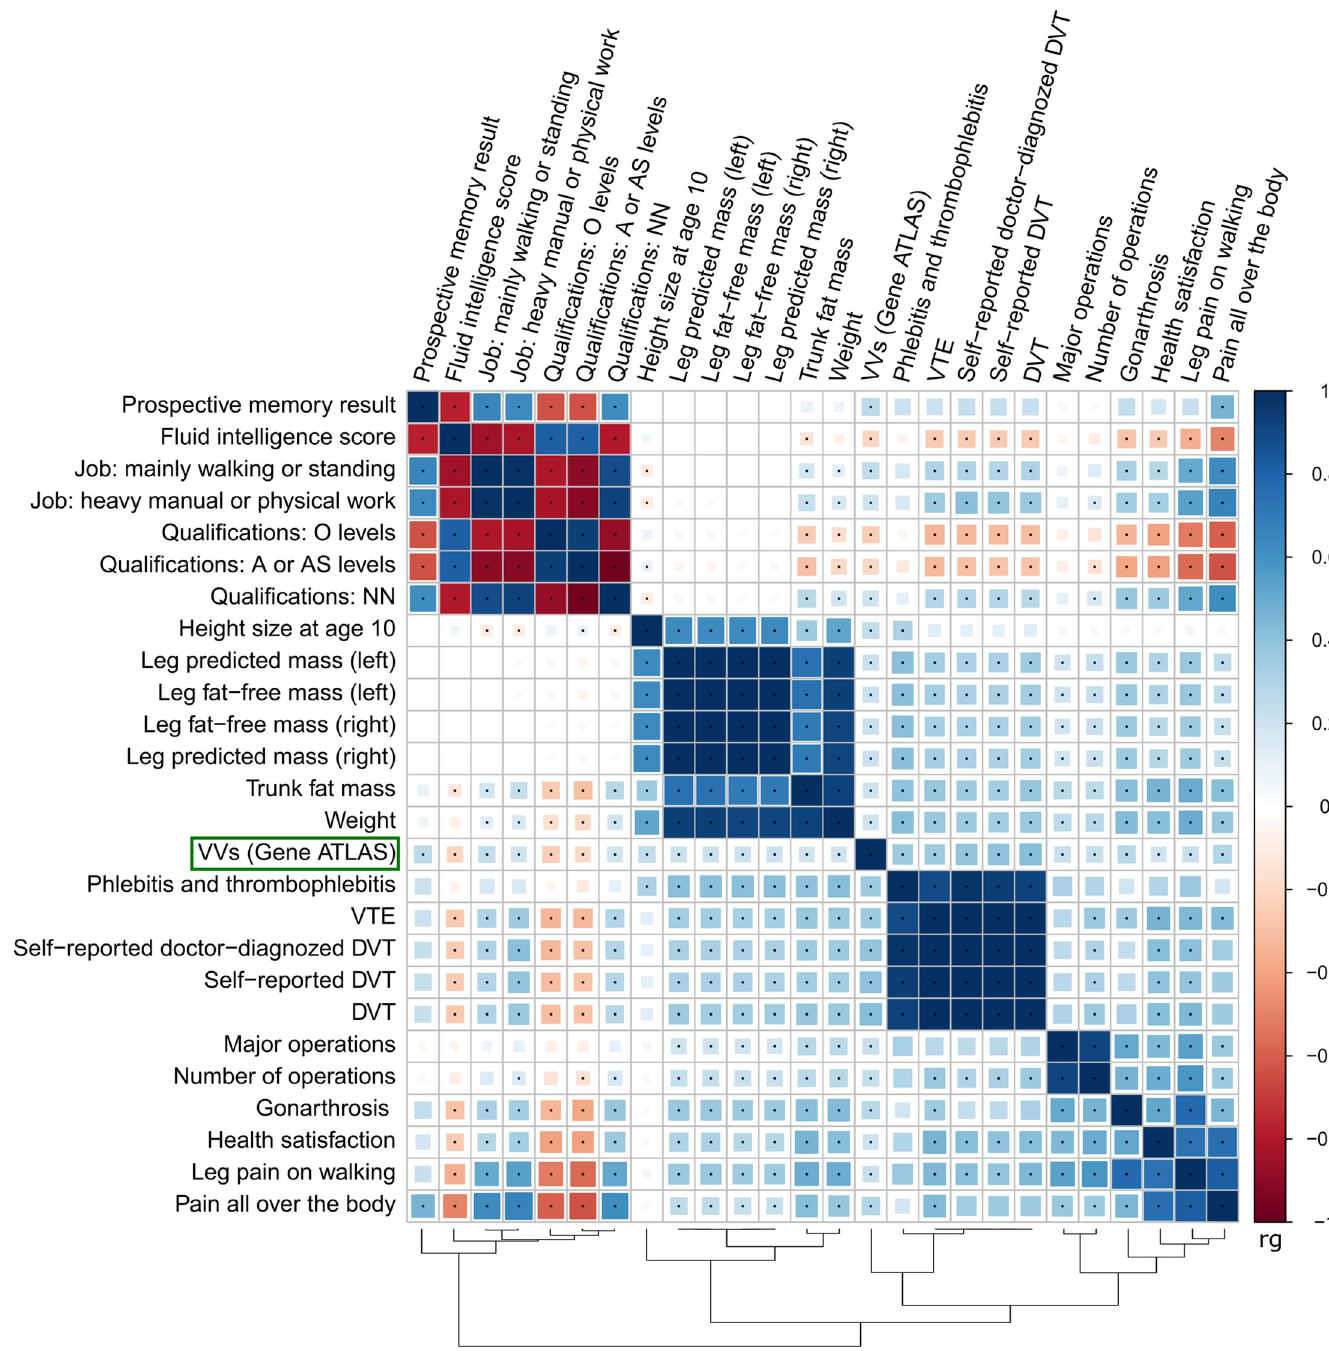
Fig 4. Matrix of genetic correlations between VVs and other complex traits. Color depicts the sign and the absolute value of genetic correlation coefficient (rg). Only the traits having |rg| � 0.2 with VVs are shown. Combinations with statistically significant rg are marked with points ( P < 3.1e-05). O levels of qualification correspond to the General Certificate of Education Ordinary Level/the General Certificate of Secondary Education; A or AS level correspond to Advanced or Advanced Subsidiary levels. “Qualifications: NN” means no qualification. Full names of traits as indicated in the Neale lab and the Gene ATLAS databases are given in S15 Table. For “Prospective memory result” and “Health satisfaction”, high scores correspond to poor performance. DVT, deep venous thrombosis; VTE, venous thromboembolism.